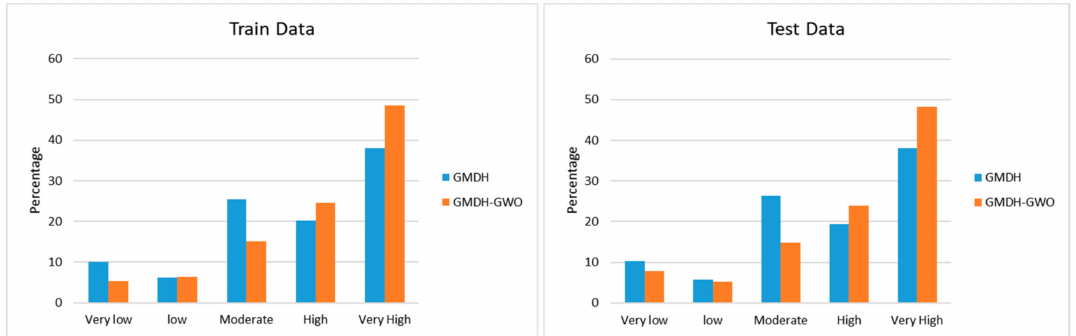
Figure 8. Percentage of landslide events within each class of landslide susceptibility